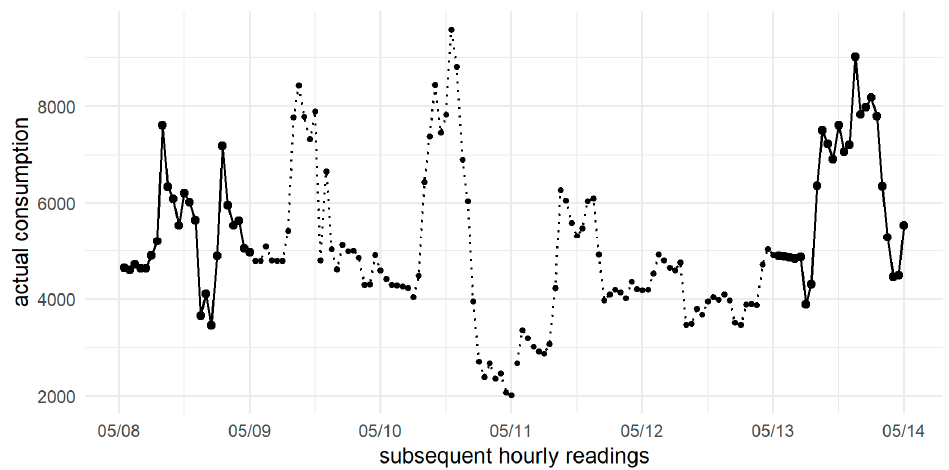
Figure 14. Actual consumption of PPE-Example5 with missing values inserted. Source: own elabo- ration.